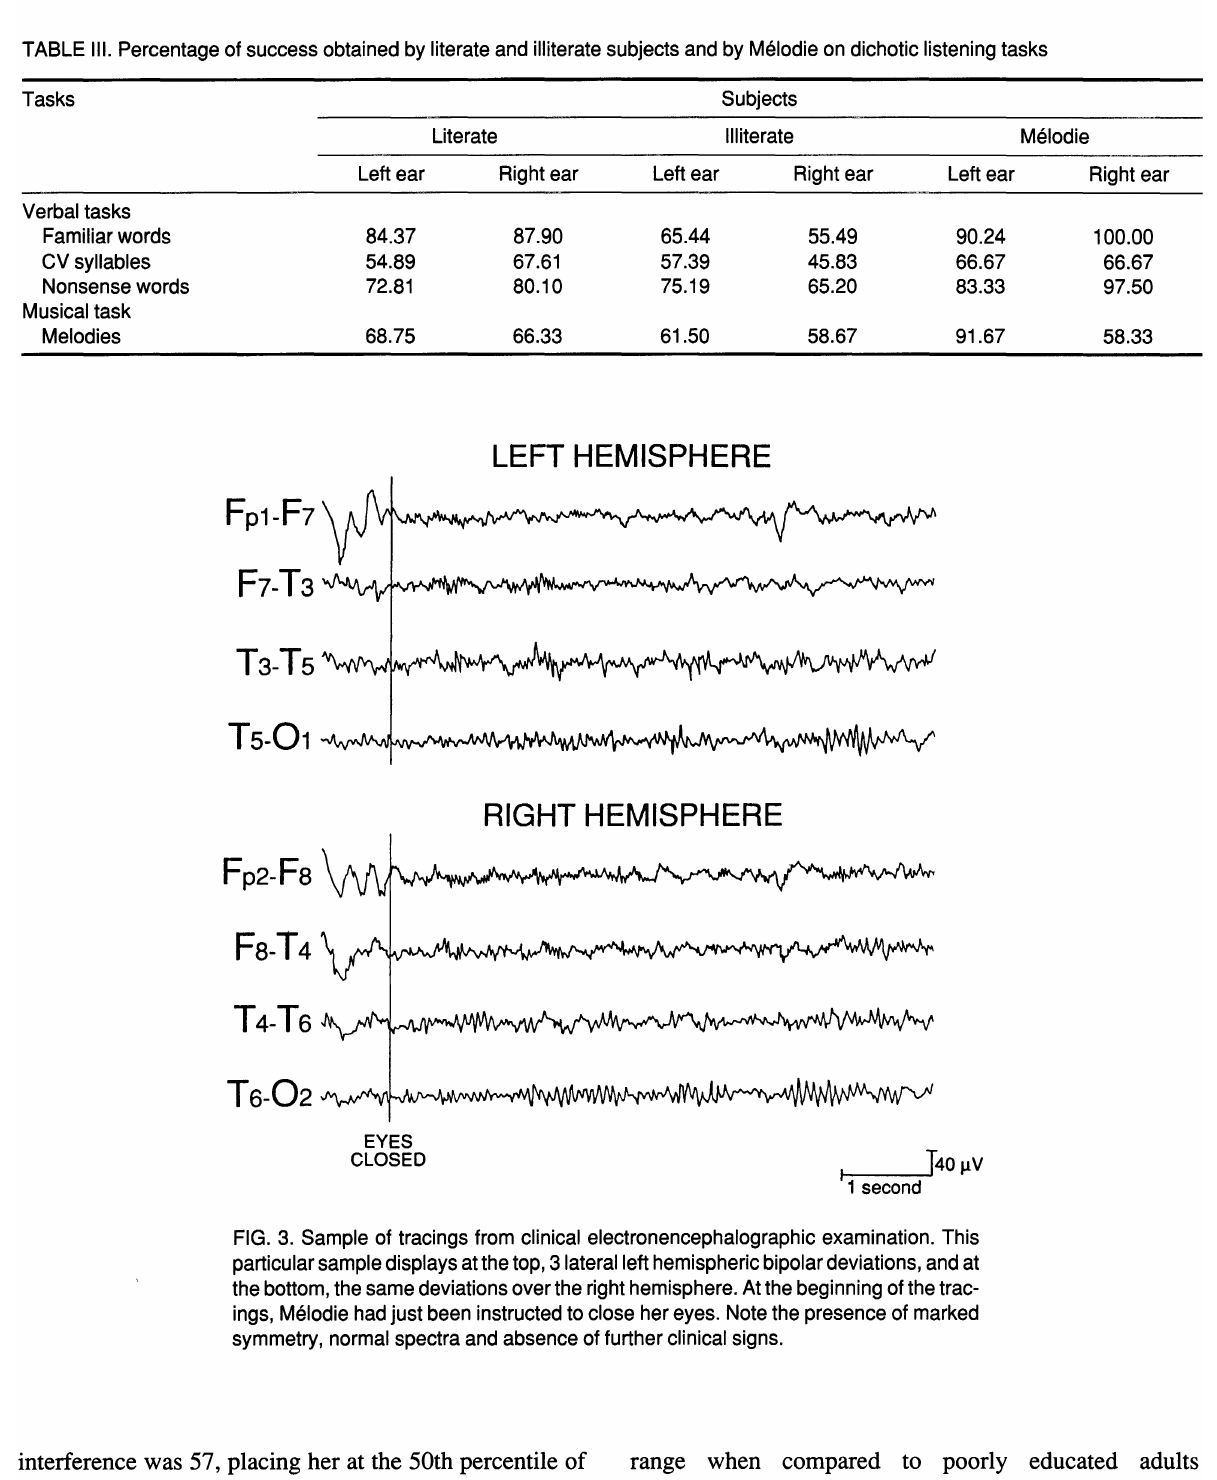
FIG. 3. Sample of tracings from clinical electronencephalographic examination. This particular sample displays at the top, 3 lateral left hemispheric bipolar deviations, and at the bottom, the same deviations over the right hemisphere. At the beginning of the trac ings, Melodie had just been instructed to close her eyes. Note the presence of marked symmetry, normal spectra and absence of further clinical